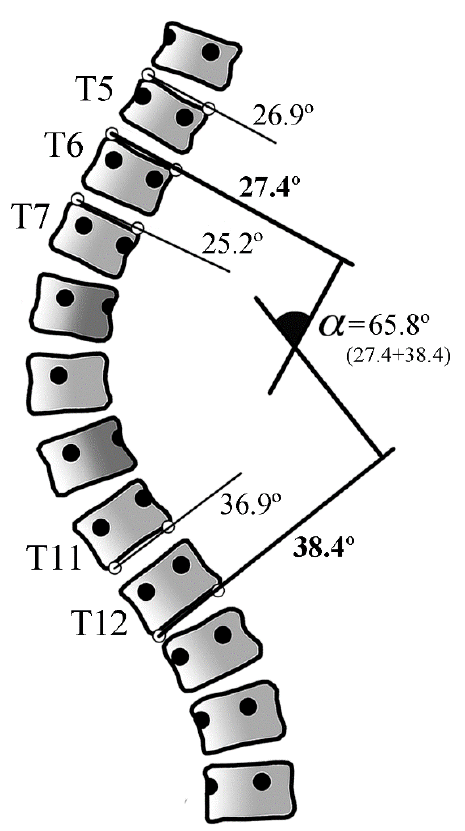
Figure 1. Several vertebrae points can be selected when there is doubt about which vertebrae are more tilted. The software will automatically choose the vertebrae that are most inclined to the horizontal (in this example, T6 (27.4°) and T12 (38.4°)). α : Cobb angle.